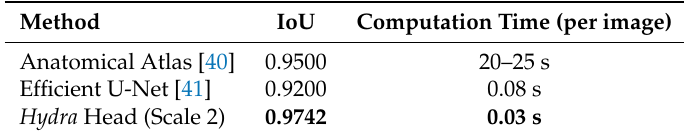
Table 5. Performance of Hydra head and existing methods for CXR lung segmentation on JSRT dataset. Bold numerical values denote superior